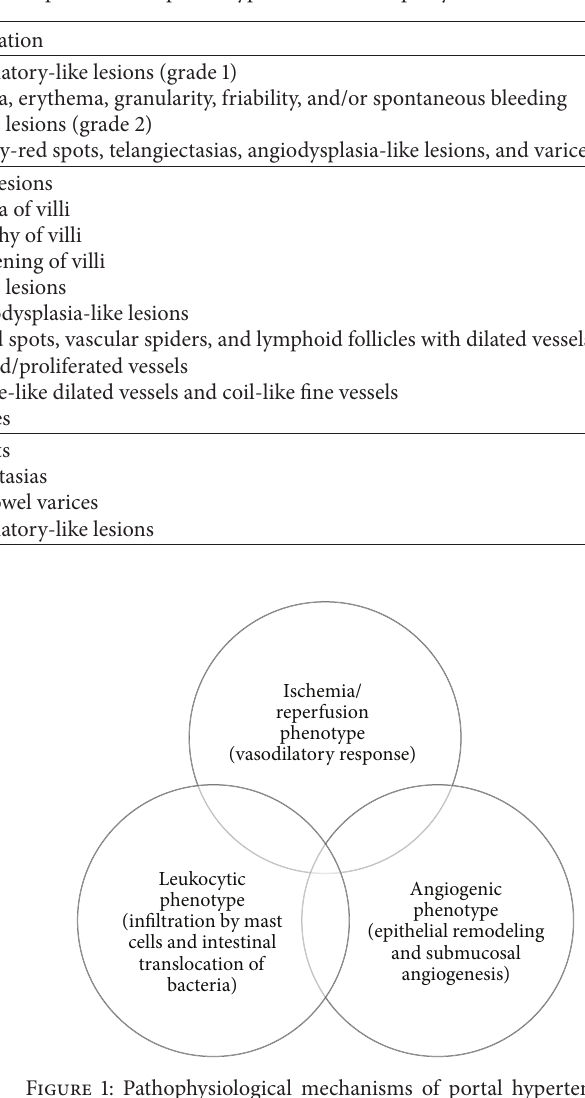
Table 1: Classifications of endoscopic abnormalities in patients with portal hypertensive enteropathy.